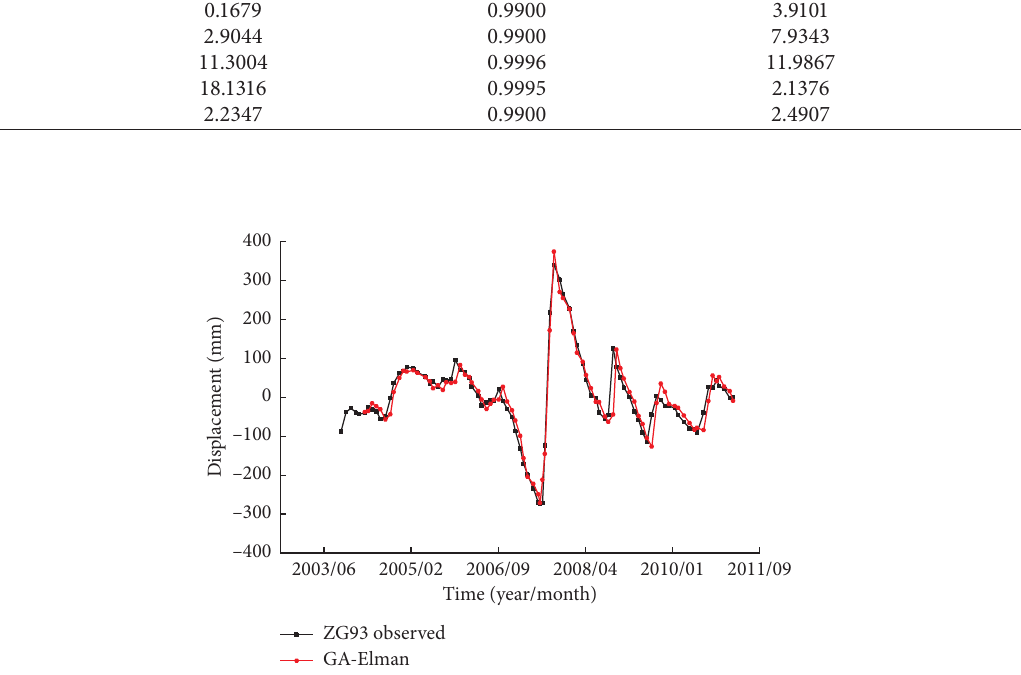
Figure 9: Fitting performance through GA-Elman model on point ZG93 in the Baishuihe landslide displacement.